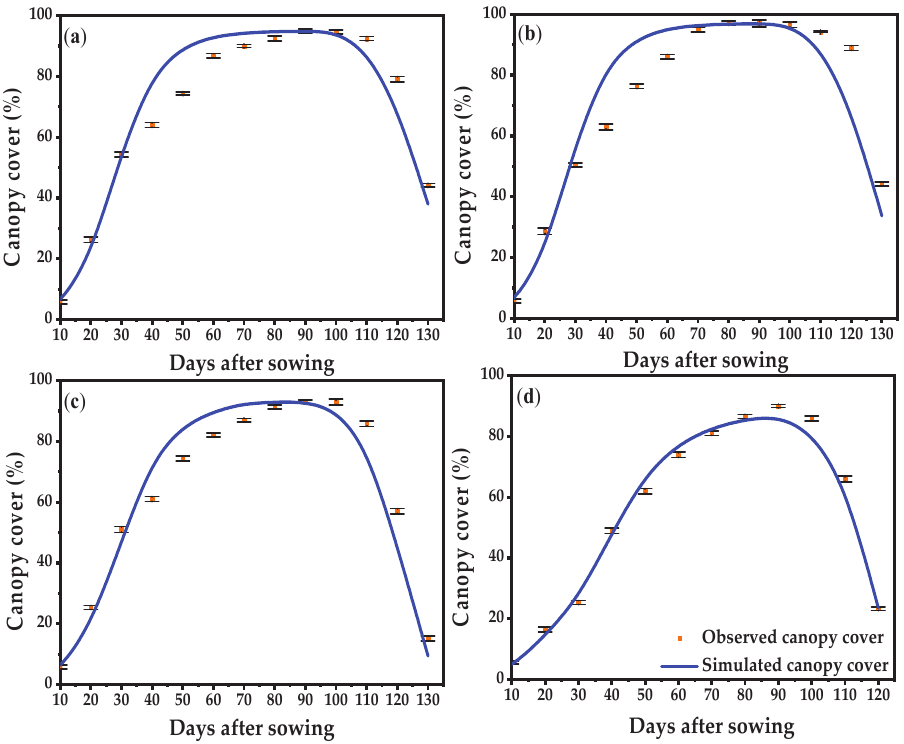
Figure 6. Observed and simulated average canopy cover during the calibration period (2019) under four irrigation regimes. FI, flood irrigation ( a ); 3IF, 3-day irrigation frequency ( b ); 6IF, 6-day irri- gation frequency ( c ); and 10IF, 10-day irrigation frequency ( d ). Error bars indicate standard devia- tion among the three replicates. (cid:11) (cid:69) (cid:12)